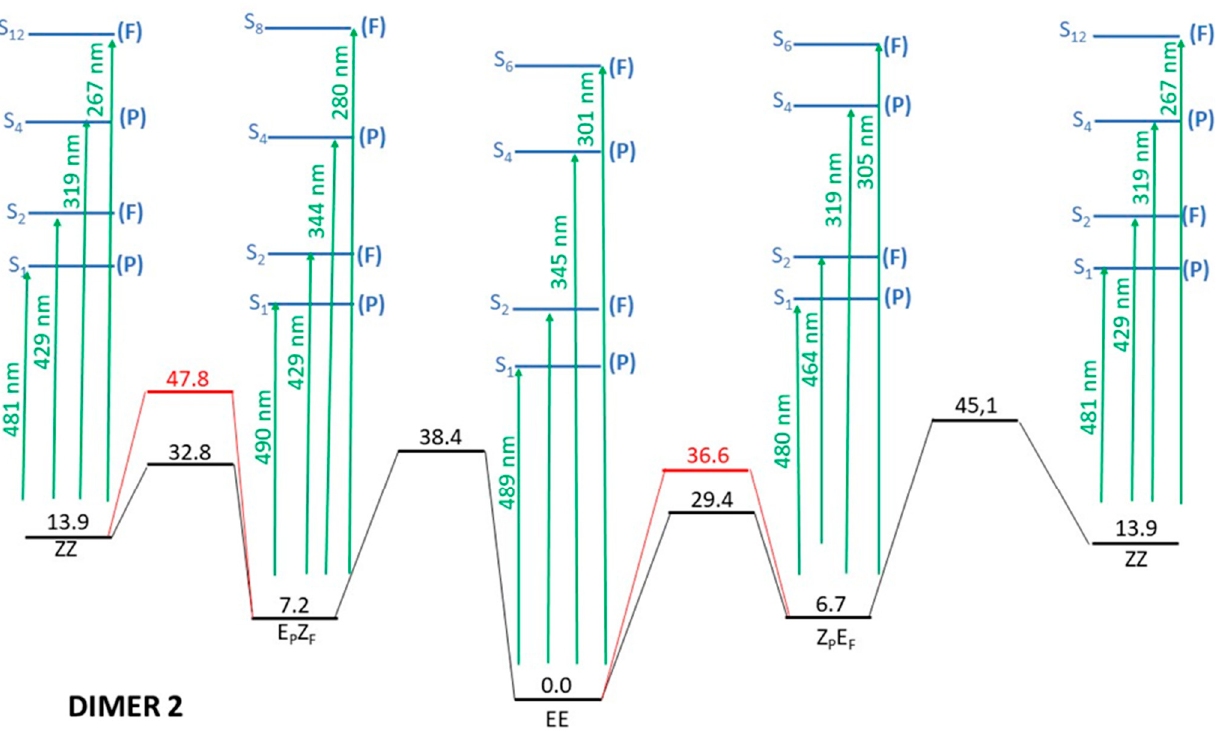
Figure 6. Full energy scheme of the ground and lowest excited electronic states of dimer 2. See text for details. Relative energies of the different structures (horizontal lines) are given in kcal/mol. Green arrows indicate the wavelengths of the vertical excitations from each conformer. Black lines indicate the ground electronic state whereas excited electronic states are in blue. Red lines correspond to crossing sections between S 0 and S 1